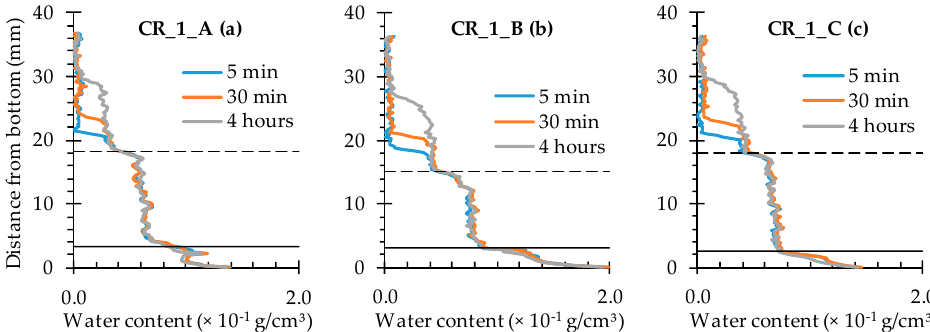
Figure 16. Water profiles along the crack as a function of exposure time for the neutron radiography images of the three standard mortar prisms containing one artificial crack: ( a ) CR_1_A; ( b ) CR_1_B; and ( c ) CR_1_C.